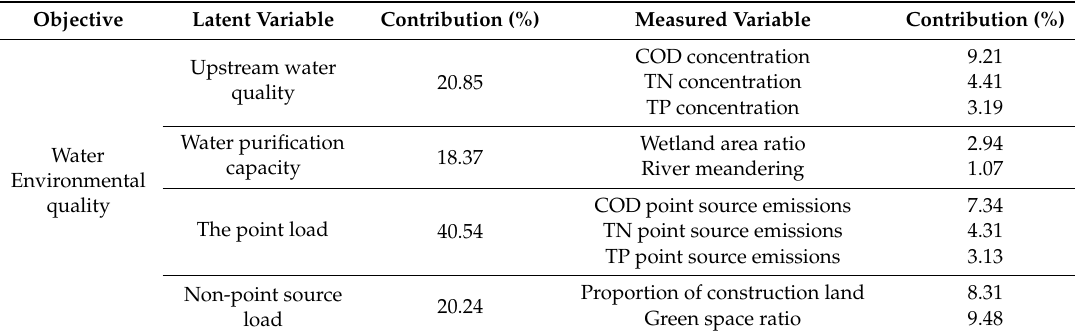
Figure 8. Standard action coefficient. Calculation of contribution rates of di ff erent measurement variables to water environment